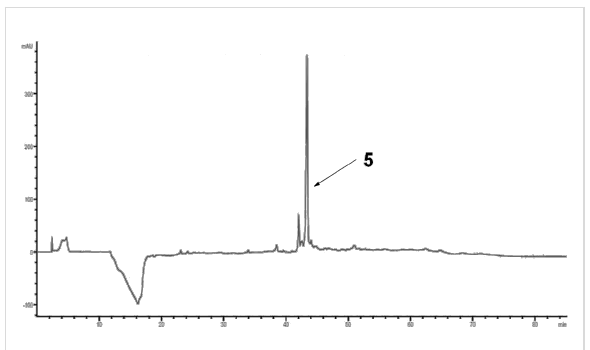
Figure 5: HPLC chromatogram of the crude products of the auto- mated solid-phase SP3 trisaccharide 5 synthesis; conditions: YMC Diol 300, H/EtOAc, 0% EtOAc (5 min) to 60% EtOAc (60 min), 254